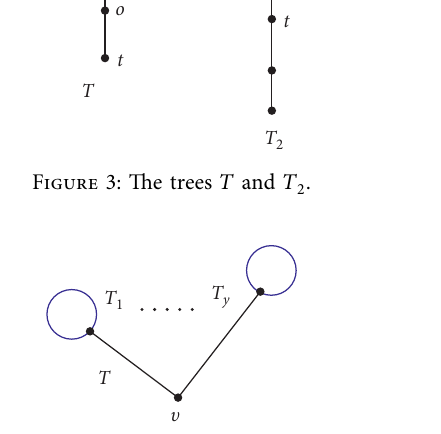
Figure 4: Branches of the tree T at v .